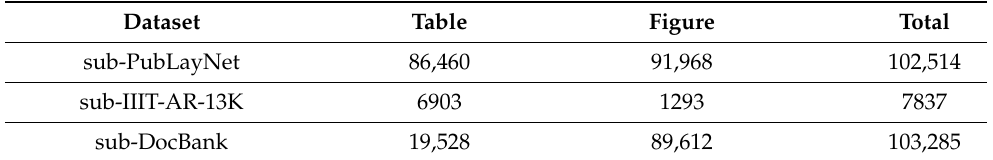
Table 3. Actual datasets are used to create subset datasets that only consist of the Table and Figure annotations. The table represents the distribution of the Table and Figure images in the training datasets of sub-PubLayNet, sub-IIIT-AR-13K and sub-DOCBANK. Table Figure